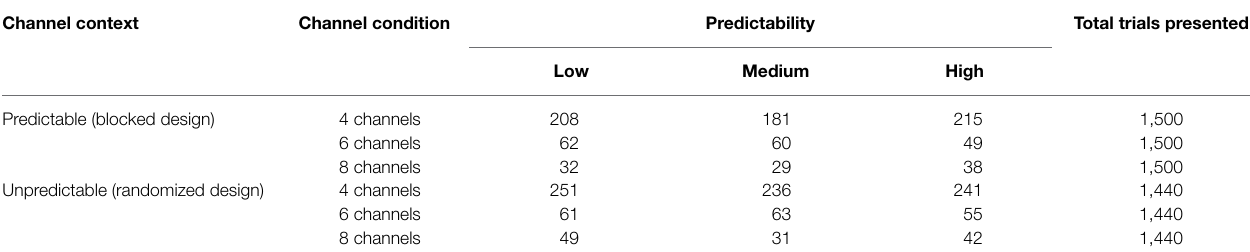
TABLE 2 | Number of trials excluded per